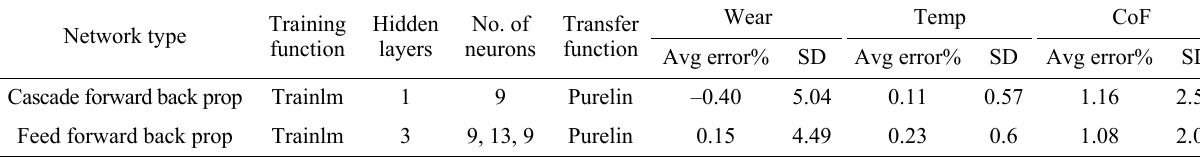
Table 20 Best predicted network for SHL-ANN and MHL-ANN architectures.